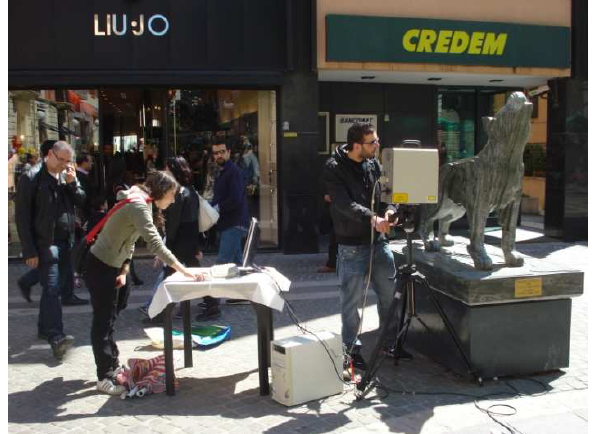
Figure 4. The positioning of the Vivid 300 before the shadowing of the statue